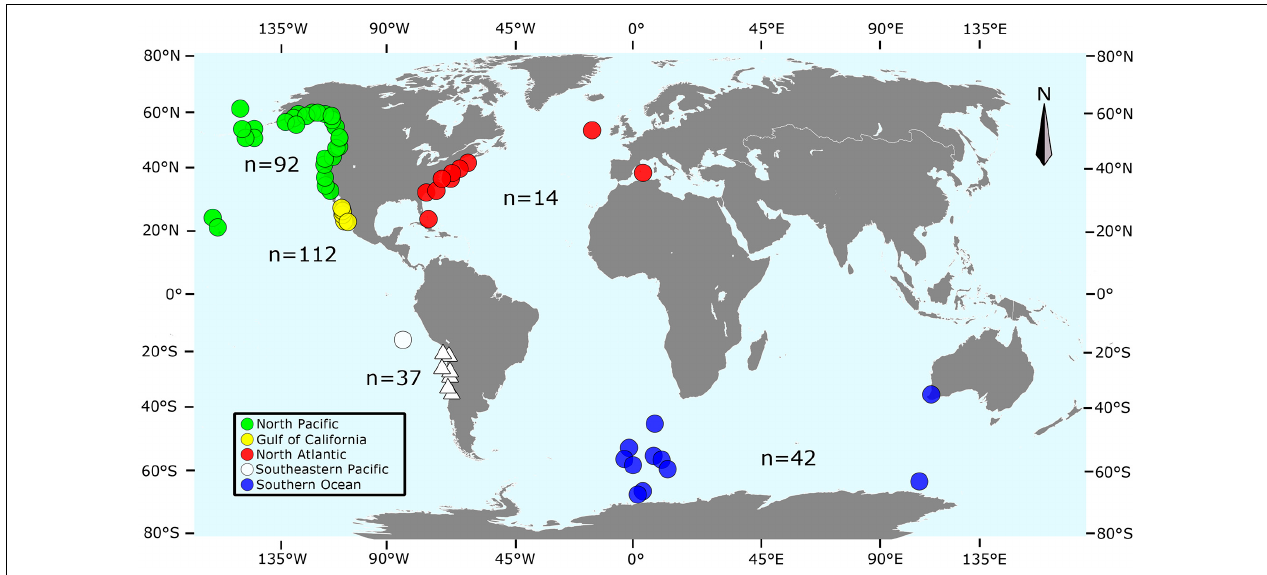
FIGURE 1 | Geographic origin of the sequences included in this study: green (North Pacific, Archer et al., 2013), red (North Atlantic, Arnason et al., 1991; Archer et al., 2013), yellow (Gulf of California, this study), blue and white (Southern Hemisphere; circles are sequences from Archer et al. (2013), and triangles from this study). Numbers indicate the number of sequences within each locality. Map adapted from Archer et al. (2013), based on SVG SILH (https://svgsilh.com/image/306338.html), released as public domain under Creative Commons CC0 1.0. Figure generated by S.K. in Inkscape 0.92.4